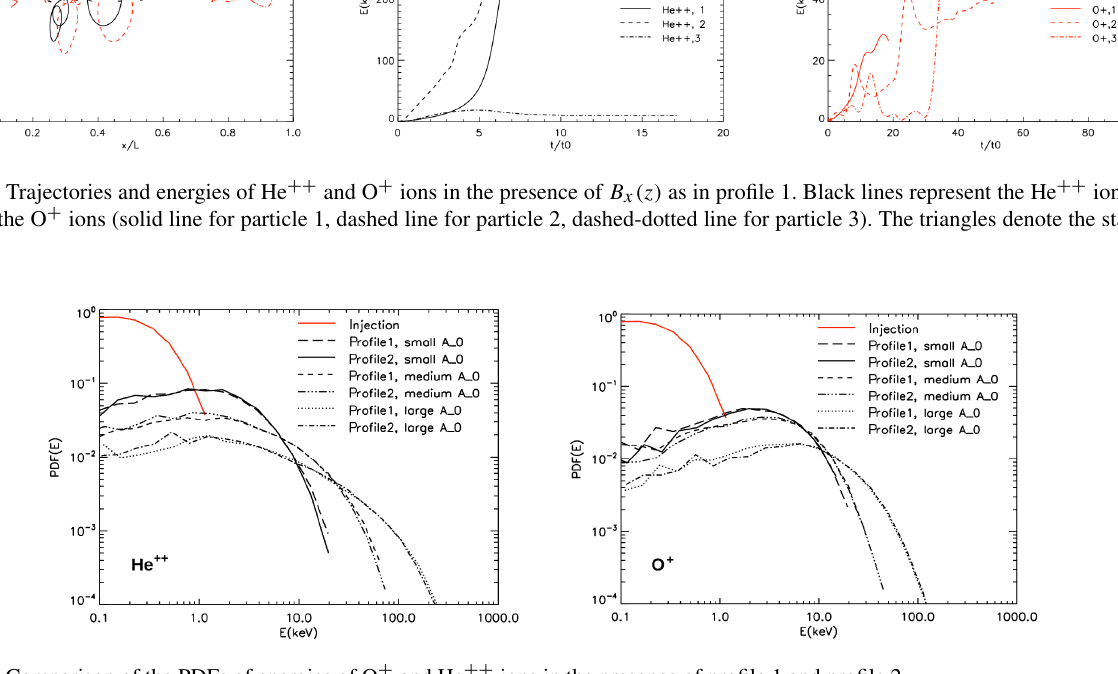
Figure 6. Comparison of the PDFs of energies of O + and He ++ ions in the presence of profile 1 and profile